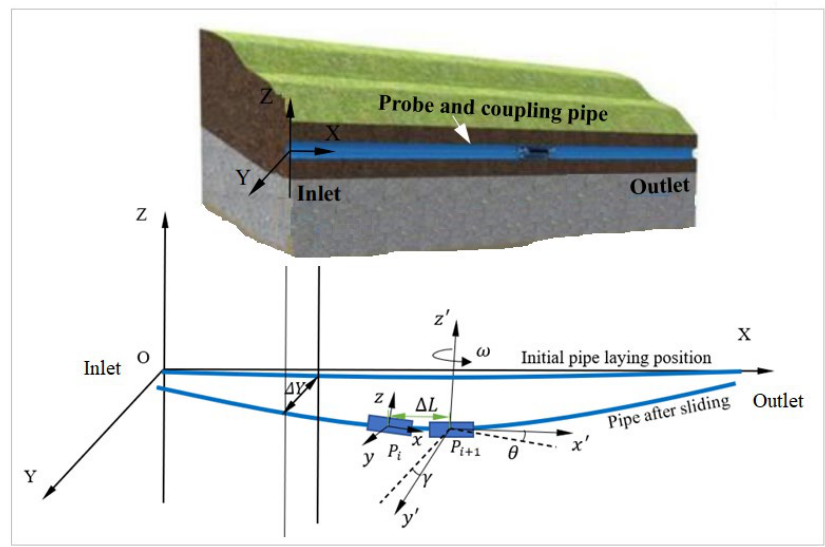
Figure 1. Principle of landslide displacement measurement.